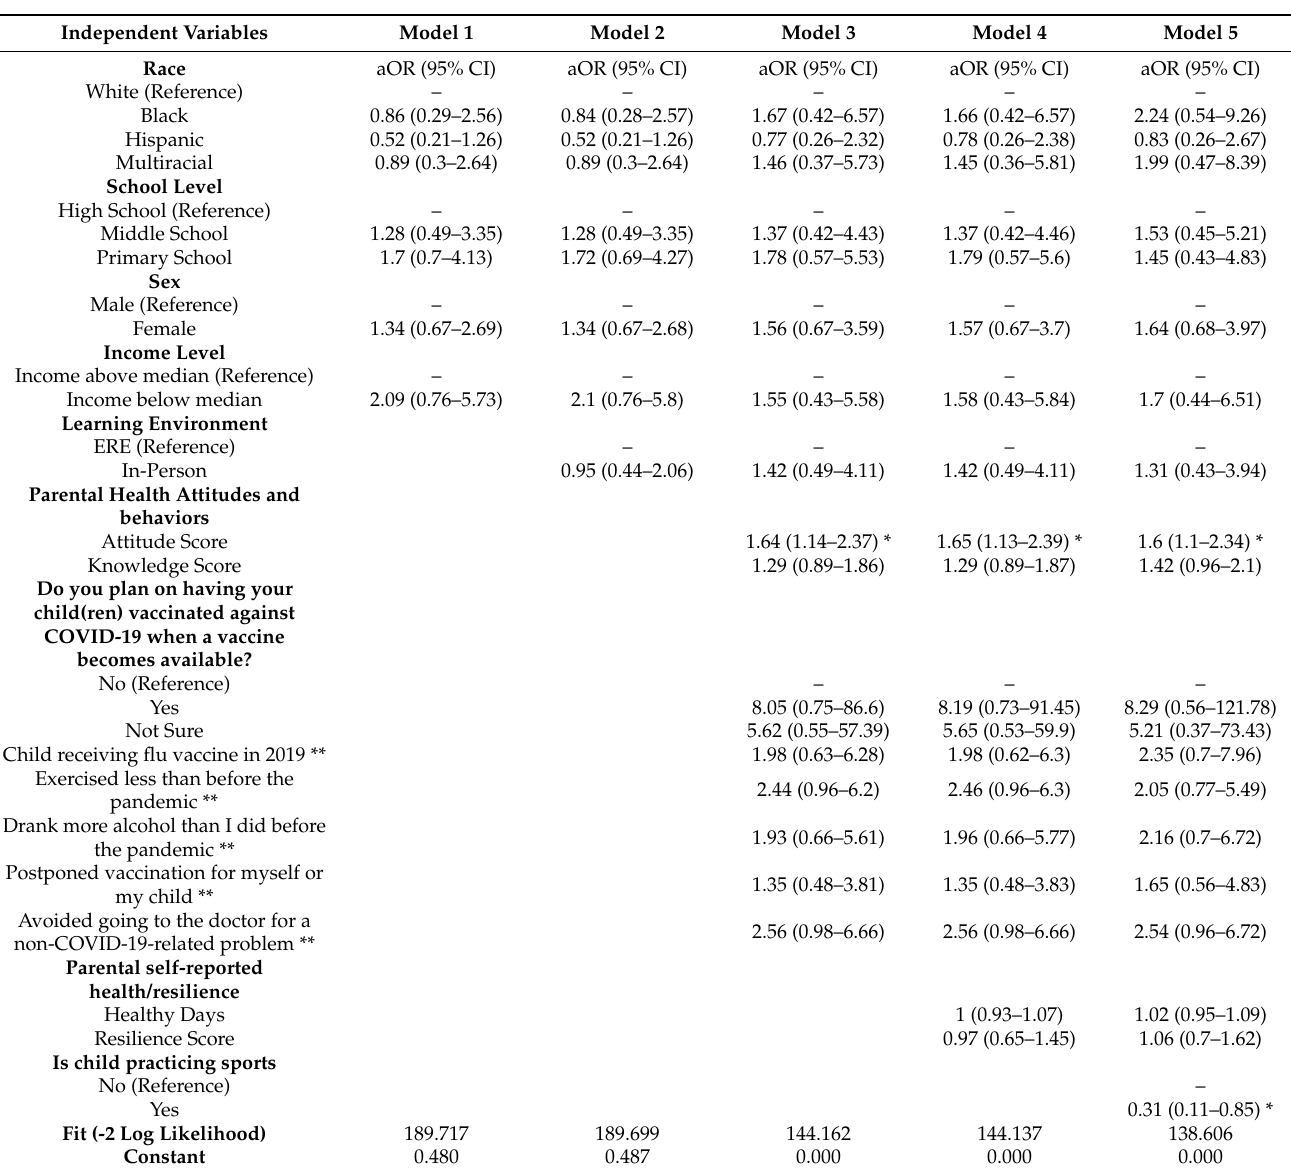
Table 4 provides the nested logistic regression models estimating the effects of distance learning on symptom-derived risk indicators for OCD. Adjusted odds ratios are included for all factors evaluated in models. A higher COVID-19 preventive attitude score was associated with a child presenting as at risk for OCD (aOR = 1.60, 95% CI = (1.10–2.34)). Similar to anxiety and depression, children’s participation in sports was found to be protective against a child presenting as at risk for OCD (aOR = 0.31, 95% CI = (0.11–0.85)). In the final model, there was no association at the significance level of p = 0.05 between OCD-related symptoms and race, sex, school level, learning environment, income, parental occupation, parental unwanted behaviors, parental attitudes towards COVID-19 vaccines, parental healthy days, and resilience score. Table 4. Nested Logistic Regression Models Examining the Effects of Sociodemographic Characteristics, Learning En- vironment, Parental Health Attitudes and Behaviors, and other Selected Factors on Students Presenting as At Risk for